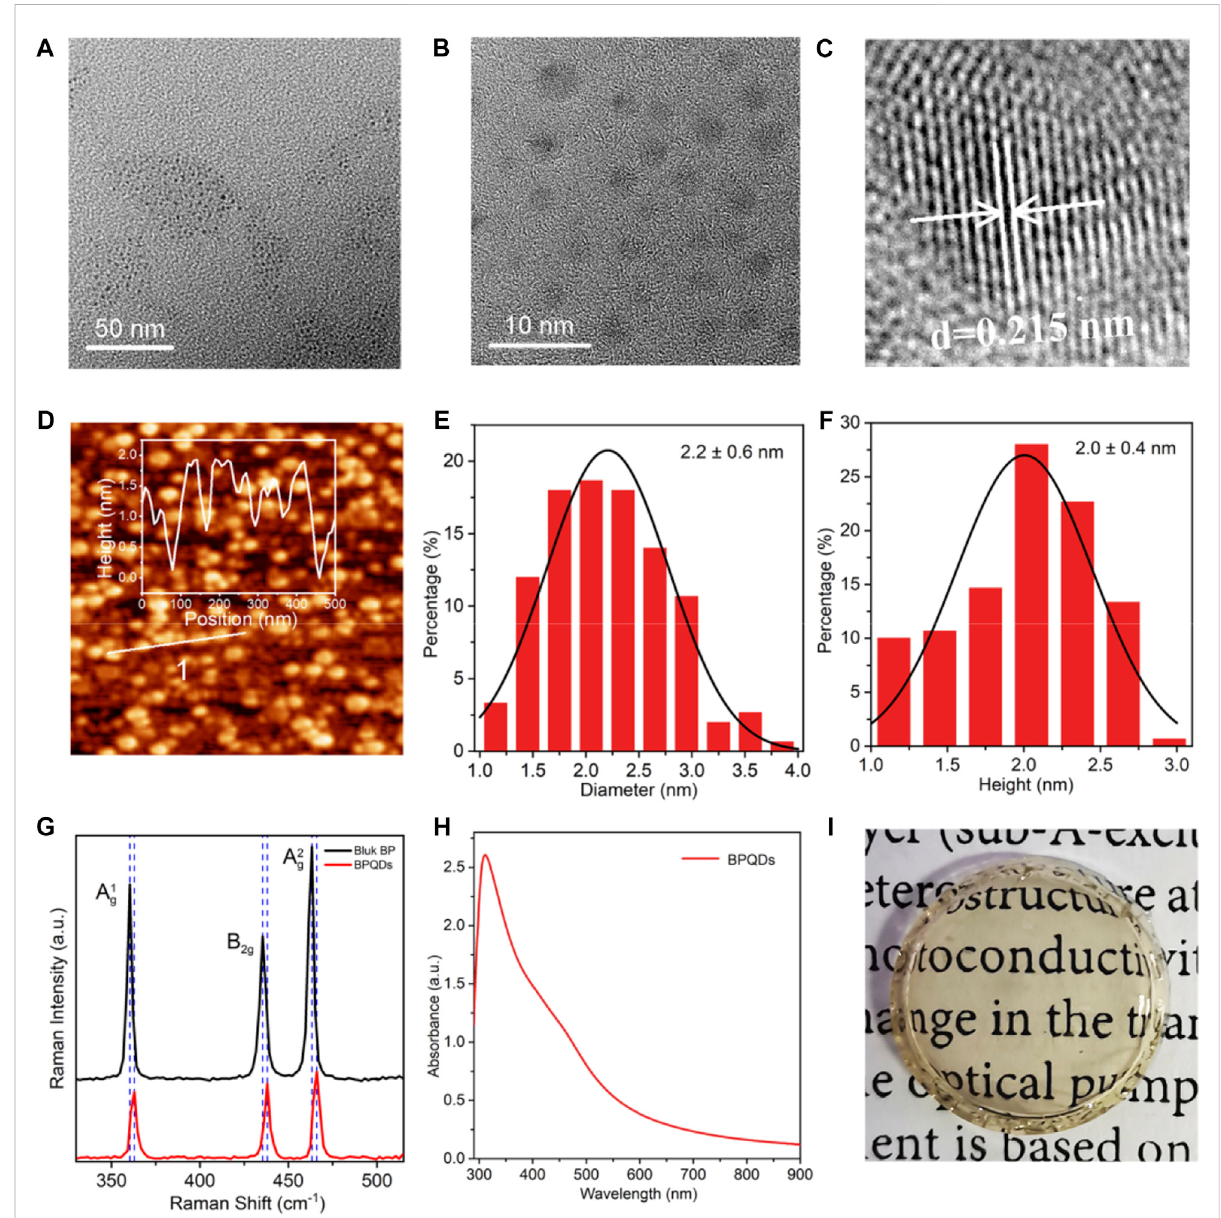
FIGURE. 1 Characterizations of BPQDs and BPQD-Ormosil gel glasses. (A,B) TEM and magni fi ed TEM images of BPQDs. (C) High-resolution TEM images. (D) AFM images of BPQDs. Inset: height pro fi le corresponding to line 1 in Figure 1 (D) . (E) Statistical analysis of thediameter of BPQDs determined by TEM. (F) Statistical analysis of BPQD height measured by AFM. (G) Raman spectra. (H) UV-vis absorption spectrum of the BPQDs. (I) Optical photograph of the BPQD-Ormosil gel